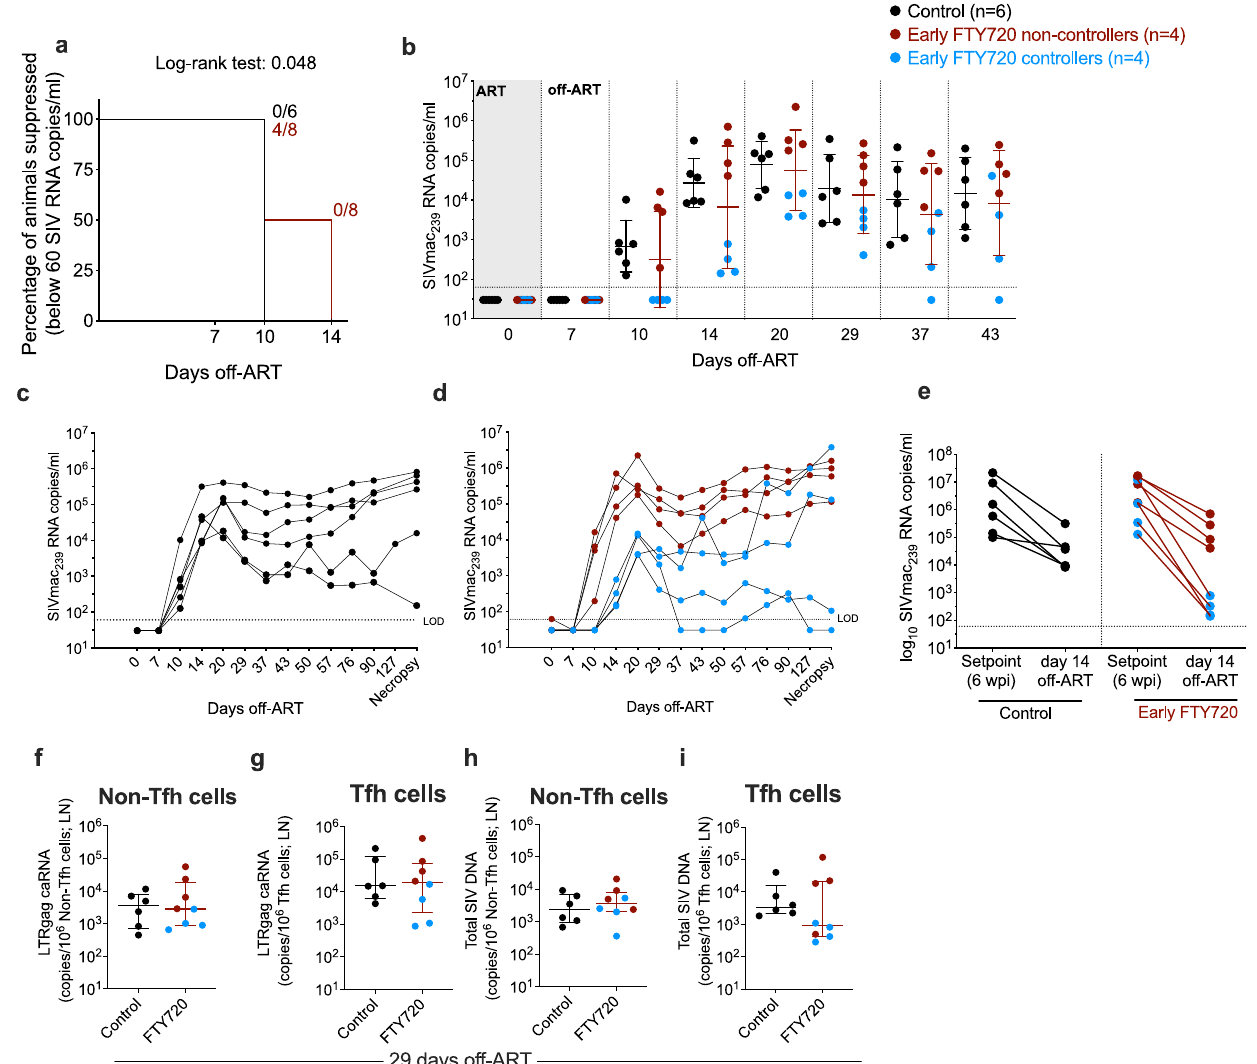
Fig.4|AsubsetofFTY720treatedanimalspresentreducedplasmaviremiaand controllers( n =4RMs),earlyFTY720controllers( n =4RMs),orcontrol(n=6RMs) Tfh infection in LN after ART interruption. a Kaplan – Meier curve showing the SIV-infected RMs at setpoint (pre-ART, 6 wpi) and at day 14 off-ART. f , g Cell- percentage of animals maintaining plasma viral loads below 60 copies/ml in the associated SIV-RNA (LTRgag caRNA; copies/10 6 cells) and ( h , i ) cell-associated SIV- fi rst2weeksoff-ART. b Plasmaviralloads(SIVmac DNA(copies/10 6 cells) in f , h non-Tfh and g , i Tfh CD4+ memoryT cellsfrom LNof 239 RNAcopies/mL)measuredby qRT-PCR longitudinally after ART interruption in early FTY720 non-controllers early FTY720 non-controllers ( n =4 RMs), early FTY720 controllers ( n =4 RMs), or ( n =4 RMs), early FTY720 controllers ( n =4 RMs), or control ( n =6 RMs) SIV- control ( n =6 RMs) SIV-infected RMs at 29 days off-ART. ART antiretroviral treat- infectedRMs.Plasmaviralloads(SIVmac 239 RNAcopies/mL)measuredbyqRT-PCR ment. Data in b are presented as the mean±SD. Data in f – i are presented as longitudinally in c control ( n =6 RMs), d early FTY720 non-controllers ( n =4 RMs), or early FTY720 controllers (n=4 RMs) individual SIV-infected RMs after ART interruption. e Plasmaviralloads (SIVmac 239 RNA copies/mL) of early FTY720non-